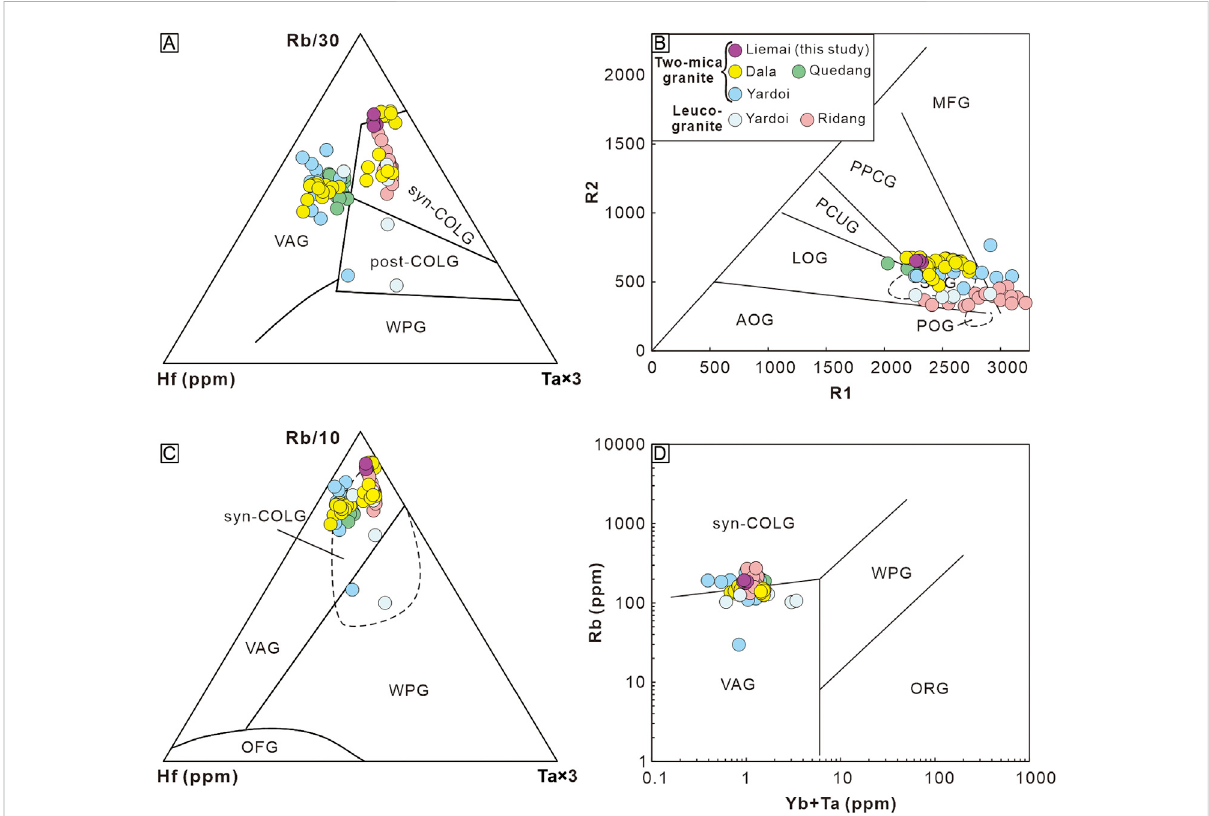
FIGURE 10 Geochemicaldiscriminationdiagramsof (A) Rb/30-Hf-Ta×3(Harrisetal.,1986), (B) R1vs.R2(BatchelorandBowden,1985), (C) Rb/10-Hf-Ta×3 (Harris et al., 1986), and (D) Rb vs. Yb + Ta (Pearce et al., 1984) for the Liemai two-mica granite. Abbreviations: MFG, mantle fractionate granitoids; PPCG, pre-plate collision granitoids; PCUG, post-collision uplift granitoids; LOG, late-orogenic granitoids; AOG, anorogenic granitoids; SCG, syn- collision granitoids; POG, post-orogenic granitoids; VAG, volcanic arc granitoids; syn-COLG, syn-collision granitoids; post-COLG, post- collision granitoids; WPG, within-plate granitoids; ORG, ocean ridge granitoids; OFG, ocean- fl oor granitoids. Data source: the granites and leucogranites are the same as in Figure